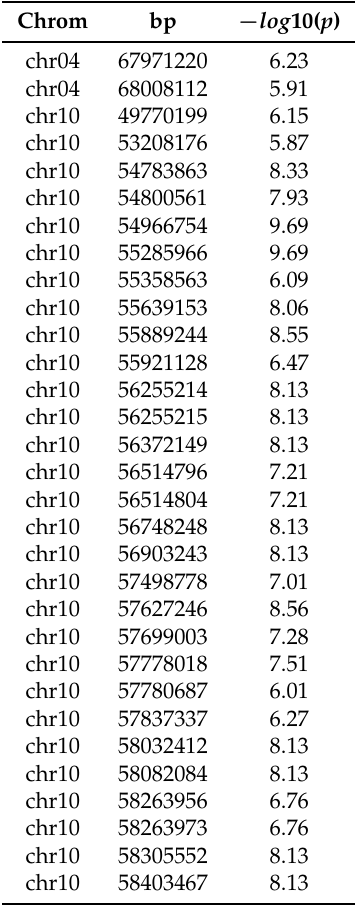
Figure 2. Results of a GWAS for ‘off-the-field’ fry color (OTF) in 2017 population—genome-wide ( left ) and zoomed in on chromosome 10 ( right ). Red line shows the QTL significance threshold (Bonferronni correction, level = 0.05). Table 3. Genome-wide association study of fry color off-the-field in 2017 population. SNP significantly associated with fry-color (Bonferronni correction, level = 0.05); SNPs are sorted by chromosome and